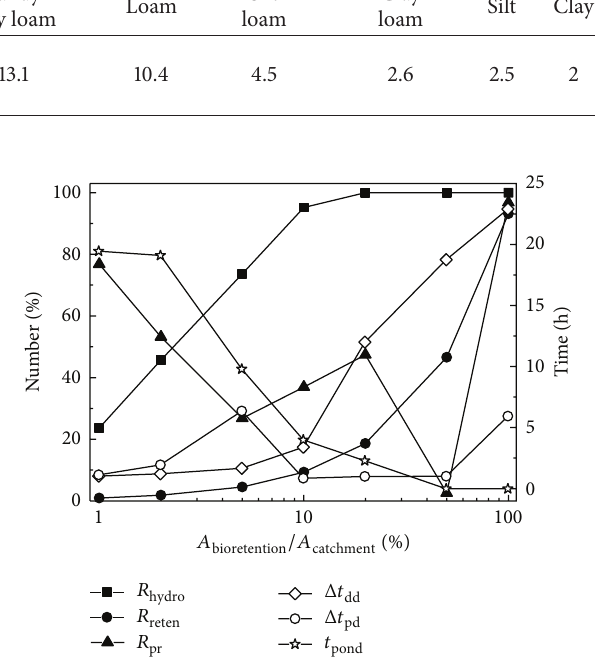
Figure 8: Hydrologic performance of bioretention measures under different bioretention areas of the catchment